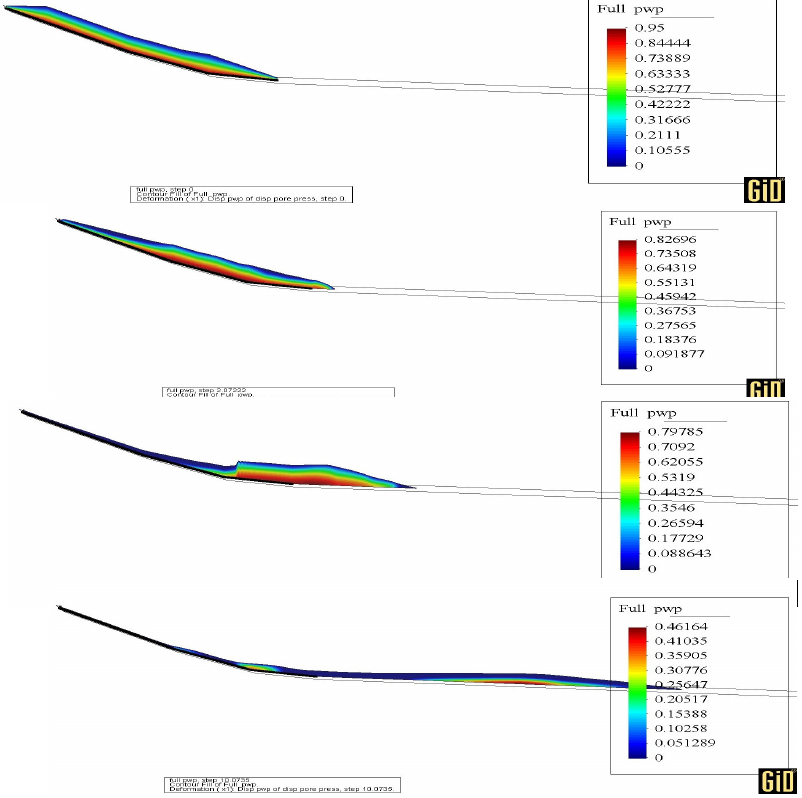
Figure 10. Pore water pressure contour at 0, 2, 5 and 10 s.